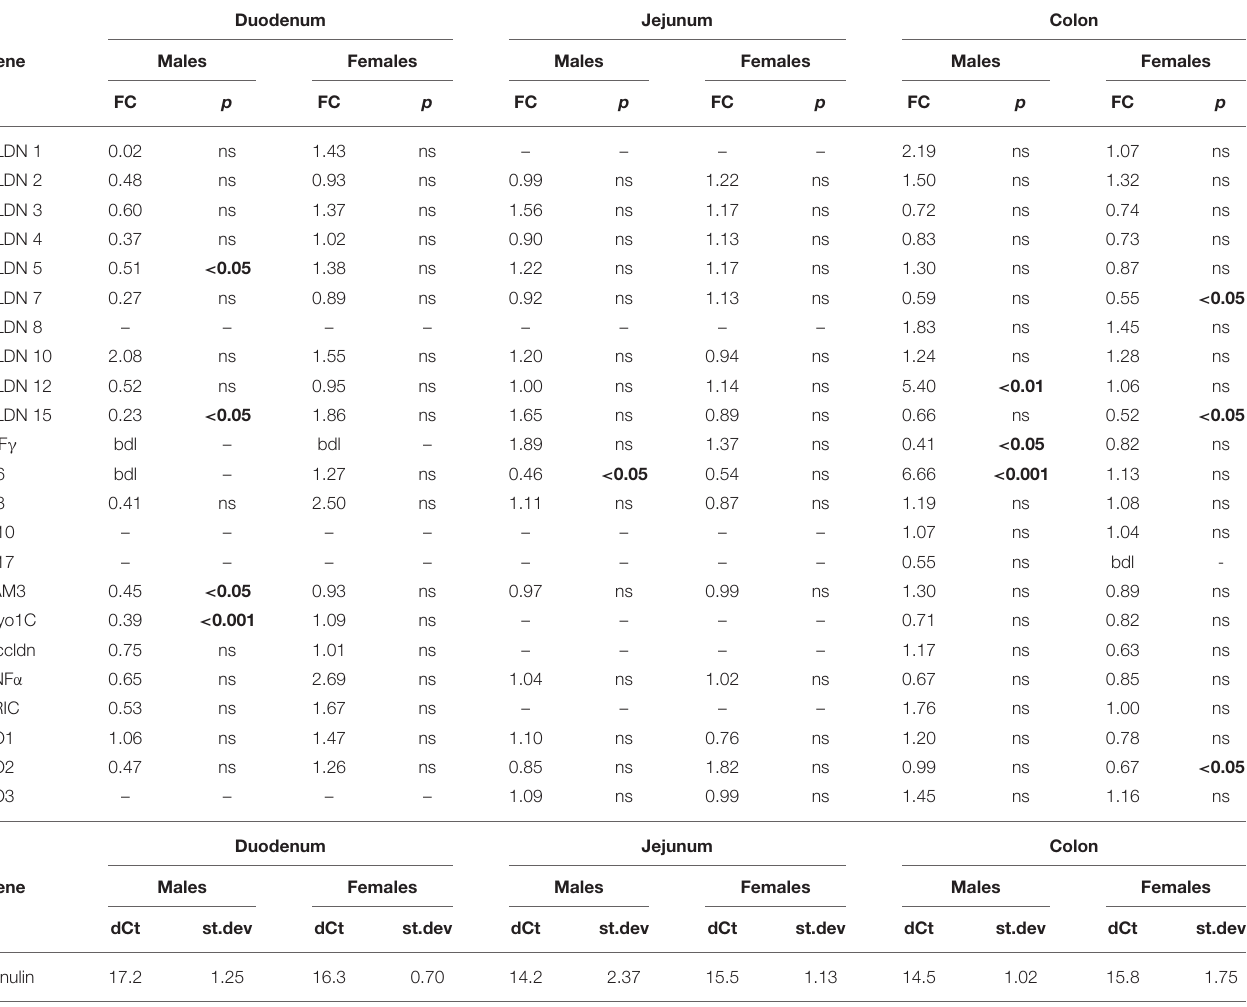
TABLE 2 | (A) List of all genes analyzed by real time PCR in the duodenum, jejunum, and colon of adult mice ( n = 6–12). A) Duodenum Jejunum Colon Gene Males Females Males Females Males Females